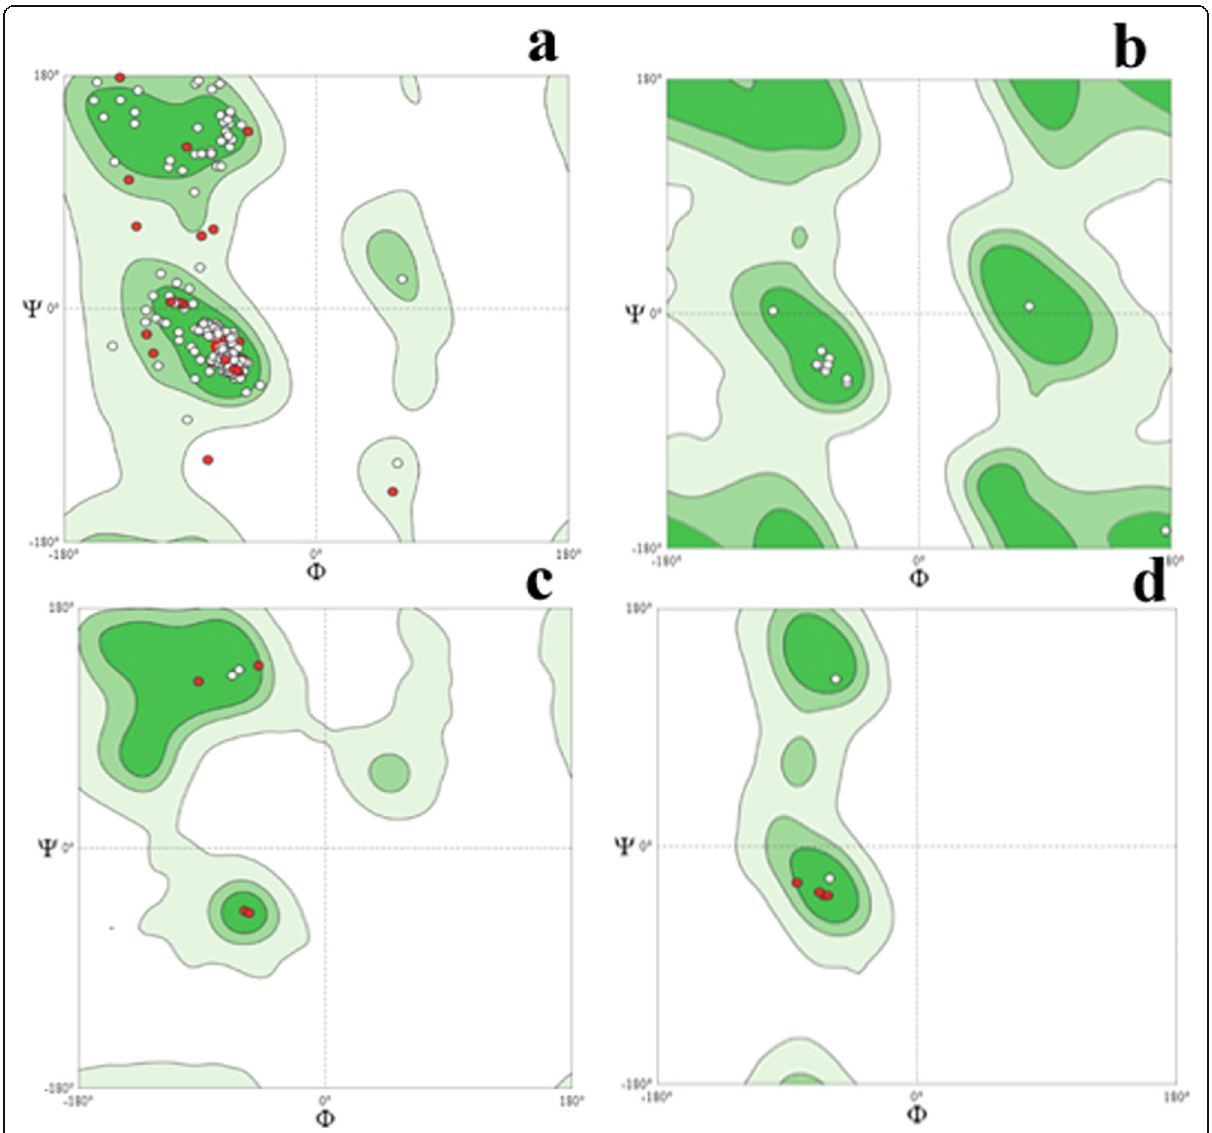
Fig. 3 Ramachandran plot analysis of protein sequences encoding SQS CDS. a The general case. b Gly residues. c Proline. d Pre-proline